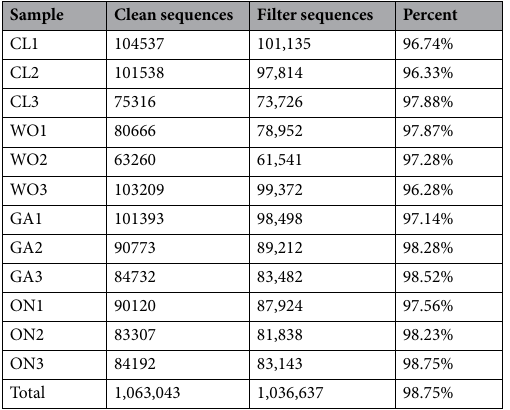
Table 1. Statistics of sequences from the four Allium species. Note: Clean sequences: the numbers of combinated sequences; Filter sequences: the numbers of sequences after filtration.